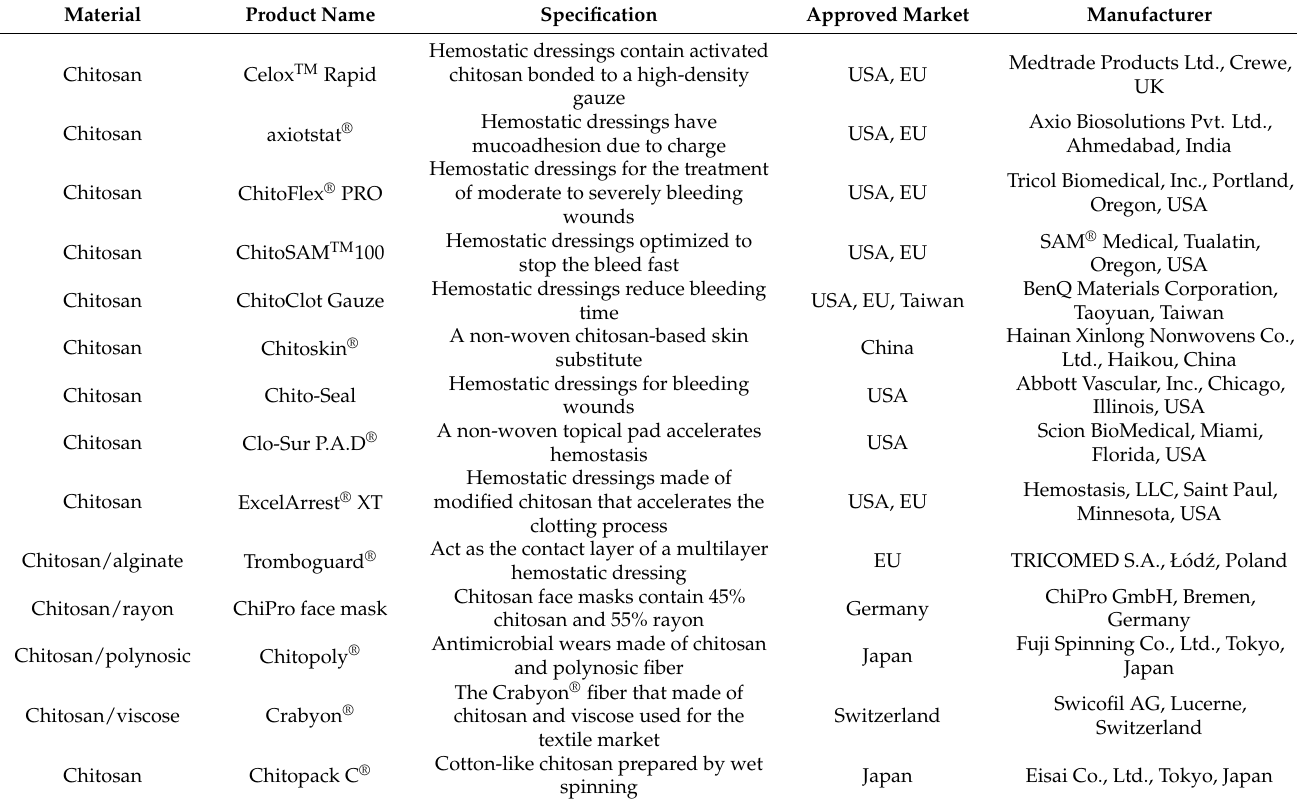
Table 1. Commercial chitosan-based fiber products on the medical wound care